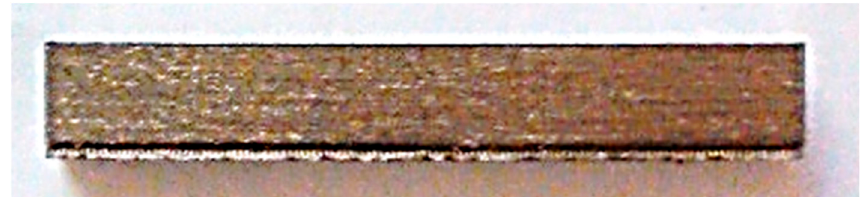
Figure 1. Experimental sample of maraging steel MS1 after DMLS.